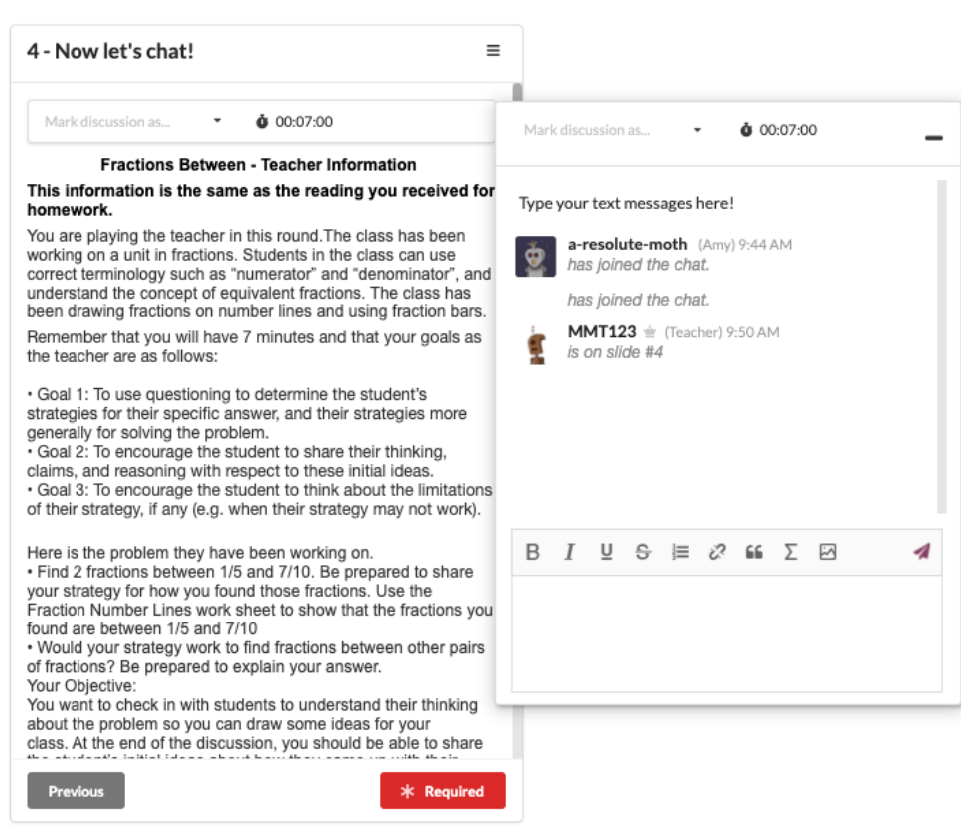
Figure 1. Screenshot of ELK showing profile information on the left and chat box on the right for a PST playing the “ teacher ” role.